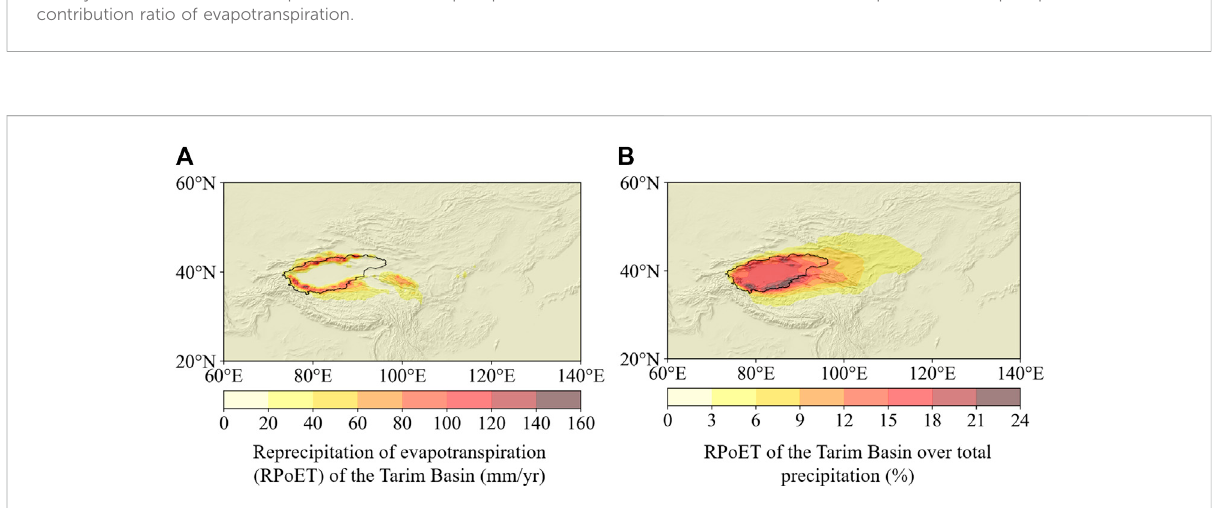
FIGURE 3 Multi-year (1980 – 2018)meanspatial distributionofRPoEToftheTarimBasin: (A) reprecipitationofevapotranspiration, (B) contributionratioof precipitation.